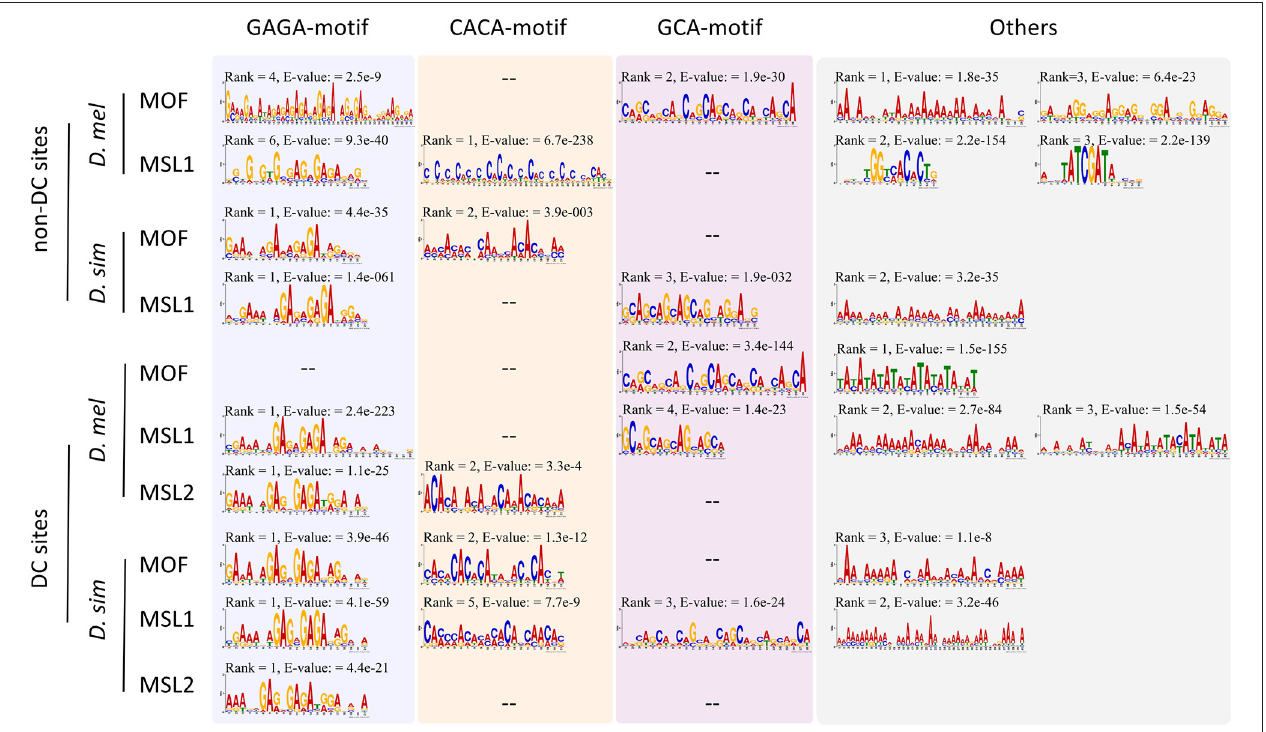
FIGURE 2 | Motifs overrepresented in DC and non-DC sites. Motif ranks are listed according to E-values ( < 0.05) calculated by MEME (Bailey et al.,